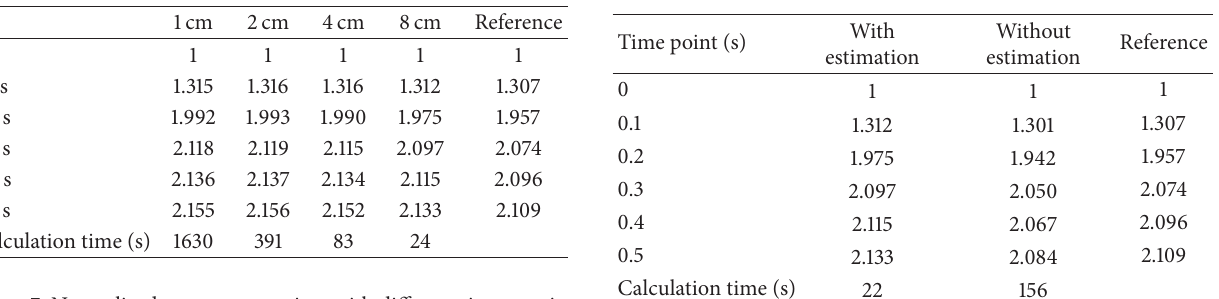
Table 6: Results for different mesh size during ramp perturbation.